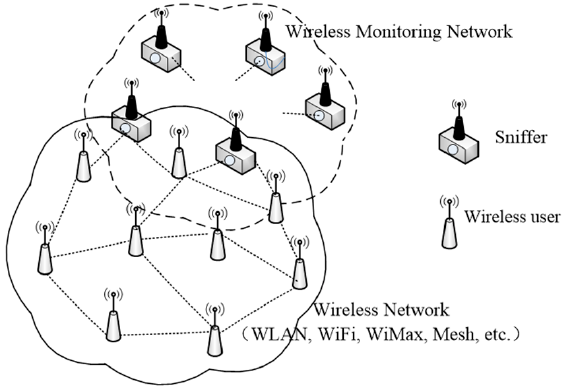
Figure 1. Wireless network and wireless monitoring network.